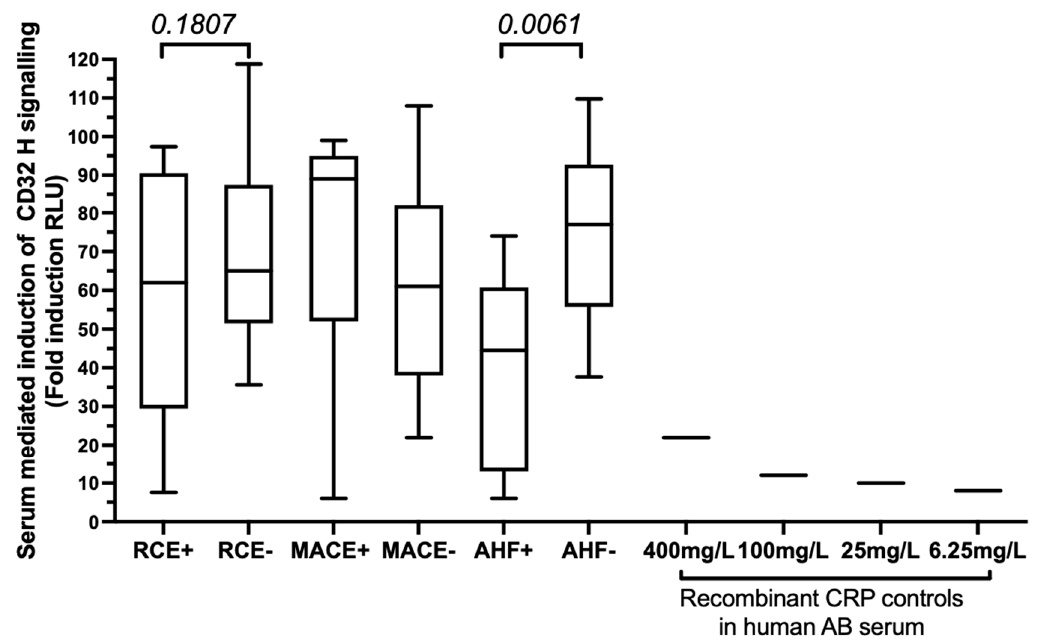
Figure 4. Evaluation of serum-induced activation of CD32-H-dependent activation in patients who bear the FCGR2A H allelic variants (HH and H/R genotypes). We assessed the serum-induced ADCP activation potential of serum from patients with the H allele at position 131 of the CD32 protein using a reporter luciferase assay in Jurkat cells transfected with the CD32-H variant. Results are expressed as fold RLU induction analyzed in reference to human AB serum of a non-immunized healthy male control donor. Recombinant CRP was diluted in the human male SAB control serum using different concentration (400 mg/mL, 100 mg/L, 25 mg/L, 6.25 mg/L). Variables that quantify serum-induced ADCP were compared in the group of RCE+ ( n = 15) and REC − patients ( n = 19) that bear the FCGR2A H allelic variant. The RCE-positive group was further stratified as MACE+AHF − patients ( n = 7) and AHF+MACE − patients ( n = 8). Serum-induced ADCP activation is described as box and whiskers plots representing medians and (10–90%) using GraphPad Prism. Comparison between groups were performed using Mann–Whitney non-parametric unpaired t tests. p values < 0.05 were reported as significant. p values ≥ 0.05 and <0.2 were indicated as a trend for significance.